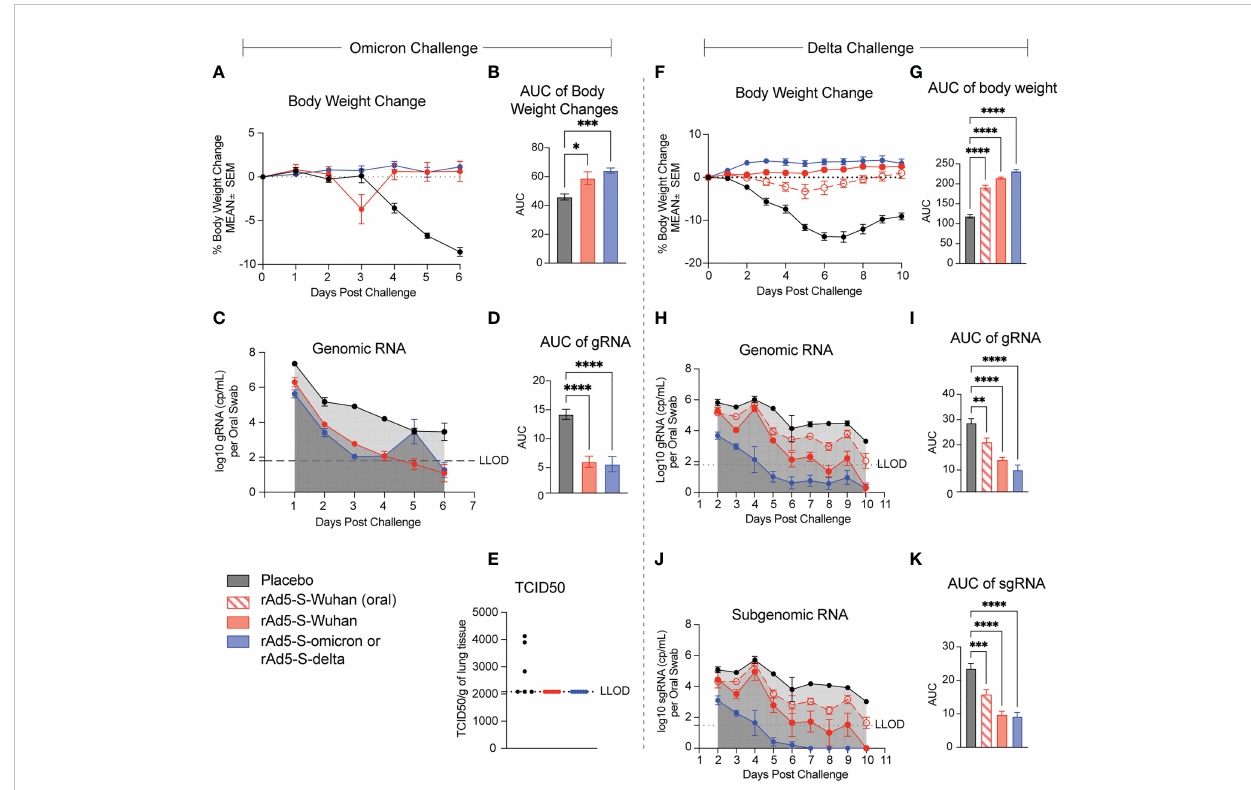
FIGURE 5 rAd5-S mediated protection of hamsters from disease caused by the omicron and delta variants. (A) Body weight changes and (B) Area under the curve (AUC) of hamsters vaccinated with rAd5-S-Wuhan (red), rAd-5-S-omicron (blue), and placebo (black) measured for six days after challenge. (C) Genomic (gRNA) detected from oral swabs of vaccinated hamsters and (D) AUC of the gRNA time course. (E) TCID50 of lung tissue at day six post infection. (F) Body weight changes and (G) AUC (One-way ANOVA) of hamsters vaccinated with oral rAd5-S-Wuhan (red – open shapes/dotted lines), rAd5-S-Wuhan (red, closed circles), rAd-5-S-delta (blue), and placebo (black) measured for 10 days after challenge. (H) Genomic (gRNA) detected from oral swabs of vaccinated hamsters and (I) AUC of the gRNA time course. (J) Subgenomic (sgRNA) and (K) AUC (one-way ANOVA) of the sgRNA time course. n=6, mean and SEM plotted. Ordinary one-way ANOVA with Dunnett ’ s multiple comparisons test. *p < 0.05, **p < 0.01, ***p < 0.005, ****p <